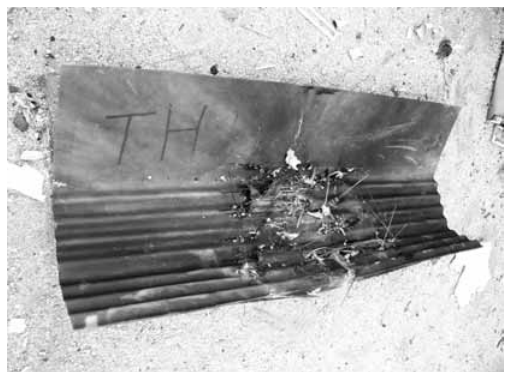
Fig. 29. Inside view of thin shield after